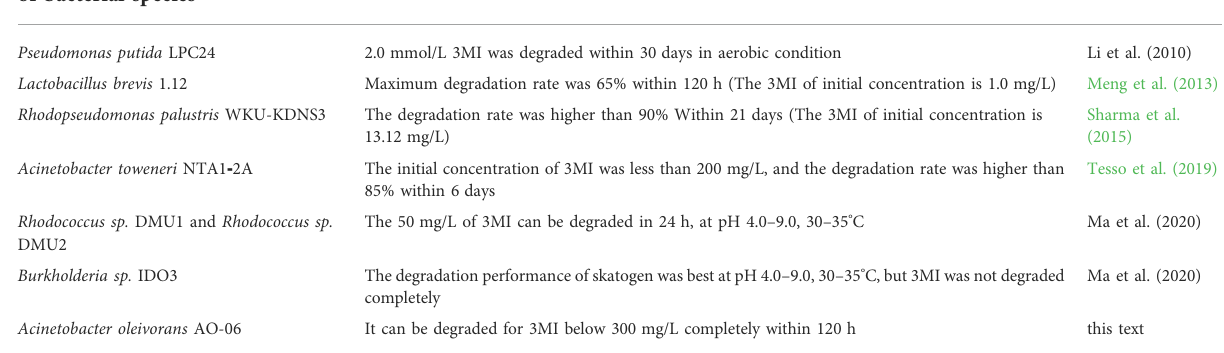
TABLE 3 Summary of known 3MI-degrading bacteria. Name of bacterial